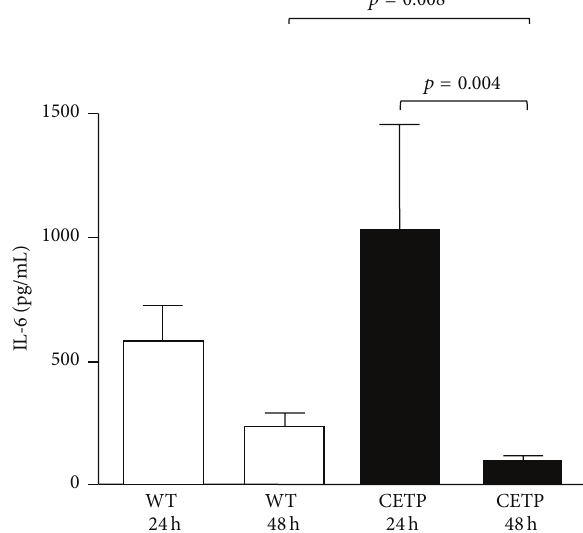
Figure 2: Plasma IL-6 levels in CETP and WT mice after CLP induced polymicrobial sepsis. Plasma IL-6 levels were measured at 24 h and 48 h after CLP by ELISA. Results are expressed as means ± SD, 𝑛 = 6 mice per group. Data were analyzed by one-way ANOVA ( 𝑝 = 0.008 : WT 48h versus CETP 48 h; 𝑝 = 0.004 : CETP 24 h versus CETP 48